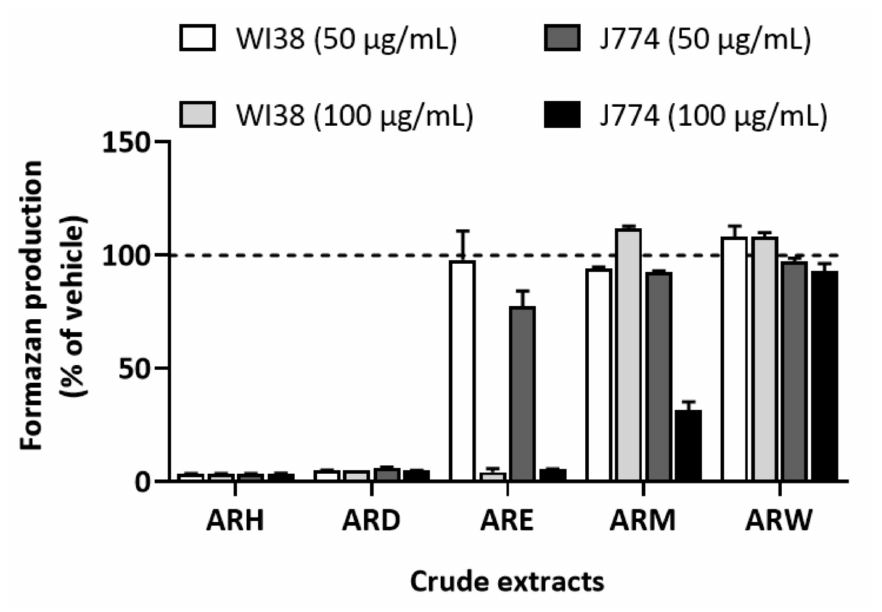
Figure 1. Effect of the crude extracts on cell viability. WI38 and J774 cells were treated with 50 and 100 µ g/mL of the crude extracts or vehicle (DMSO and EtOH-H 2 O (25:75)) for 72 h. Then, an MTT assay was performed. Data are expressed as mean ± SEM. n = 2 in